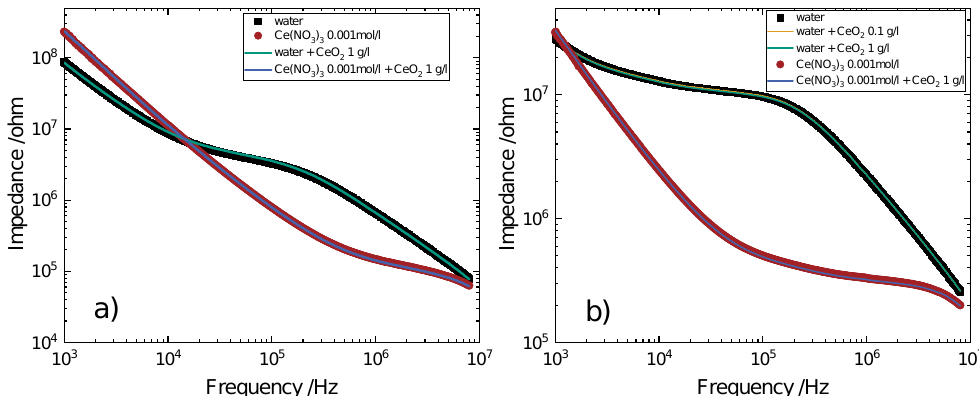
Figure 8. Impedance versus frequency for deionized water, cerium nitrate with a concentration of 0.001 mol/L and ternary systems of water, cerium nitrate and ceria. ( a ) electrode design Geo1 (5 mm distance, 5 mm width) and ( b ) electrode design Geo9 (20 mm distance, 20 mm